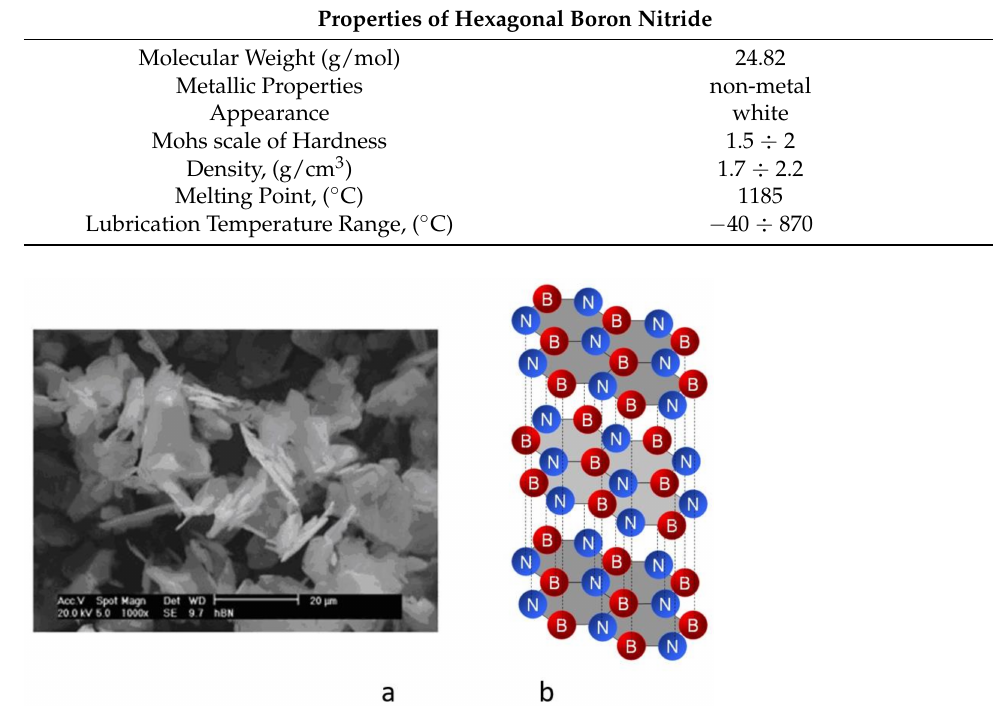
Figure 3. Hexagonal boron nitride (h-BN) ( a ) scanning microscope image; ( b ) crystallographic lattice diagram